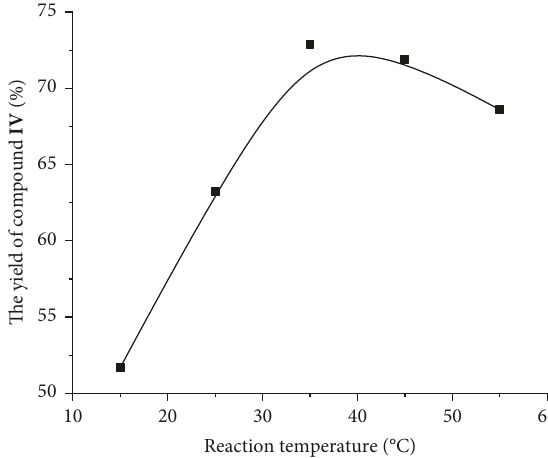
Figure 9: Impact of reaction